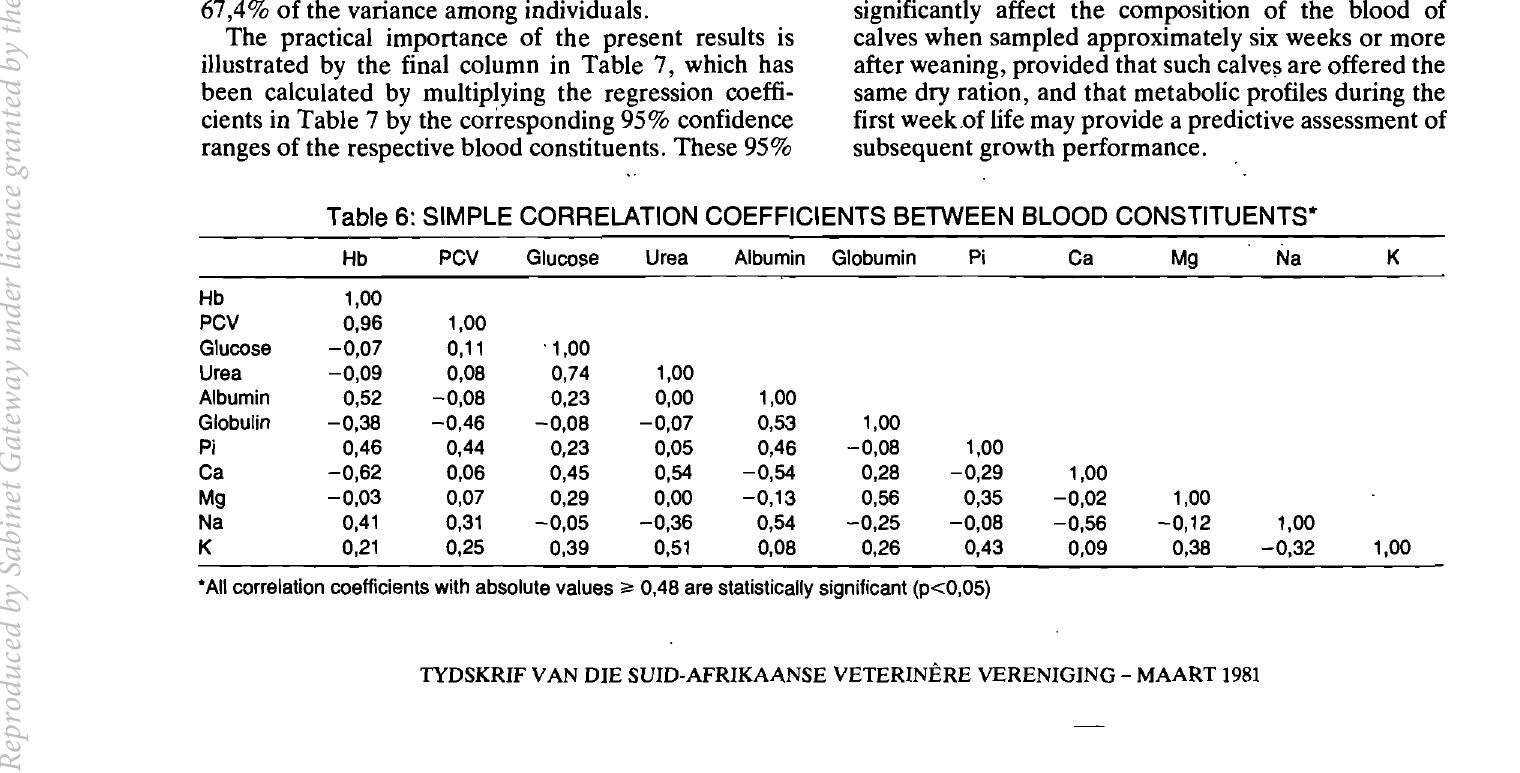
Table 6: SIMPLE CORRELATION COEFFICIENTS BETWEEN BLOOD